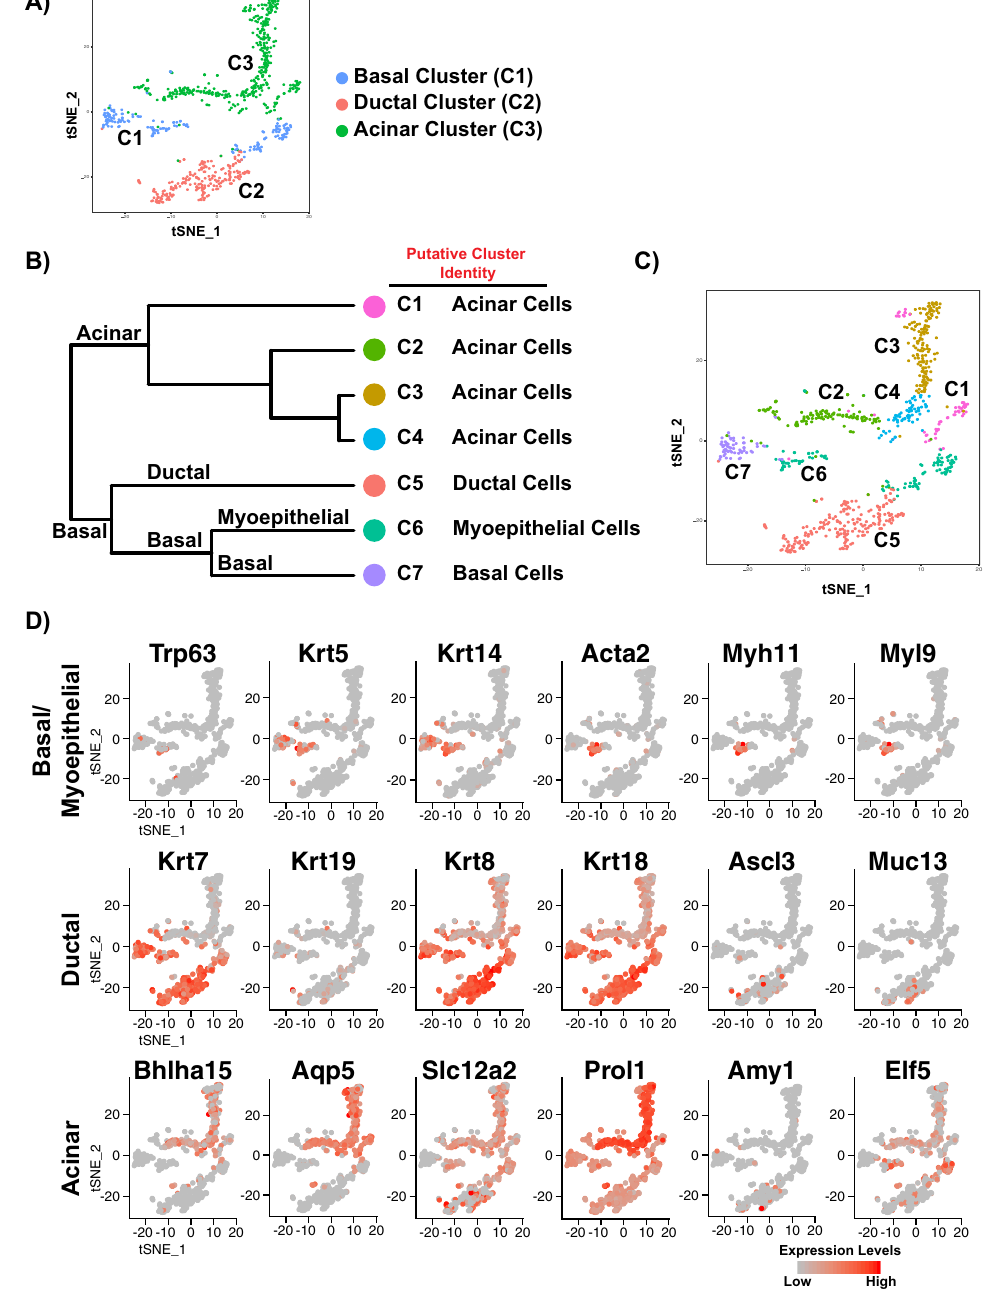
Figure 1. Identification of salivary gland epithelial cell clusters by single-cell RNA sequencing. ( A ) Salivary gland epithelial cell transcriptomes visualized with t-distributed stochastic neighbor embedded (t-SNE), colored according to unsupervised clustering. ( B ) Hierarchical clustering analysis based on the log-transformed mean expression values of the 7 clusters. The tree was computed based on Spearman’s rank correlation with Ward linkage. ( C ) t-SNE plot based on the hierarchical clustering analysis performed in panel B above. ( D ) Epithelial cell clusters were interrogated for the expression of known basal, myoepithelial, ductal and acinar genes to determine their patterning amongst the cell clusters. C-